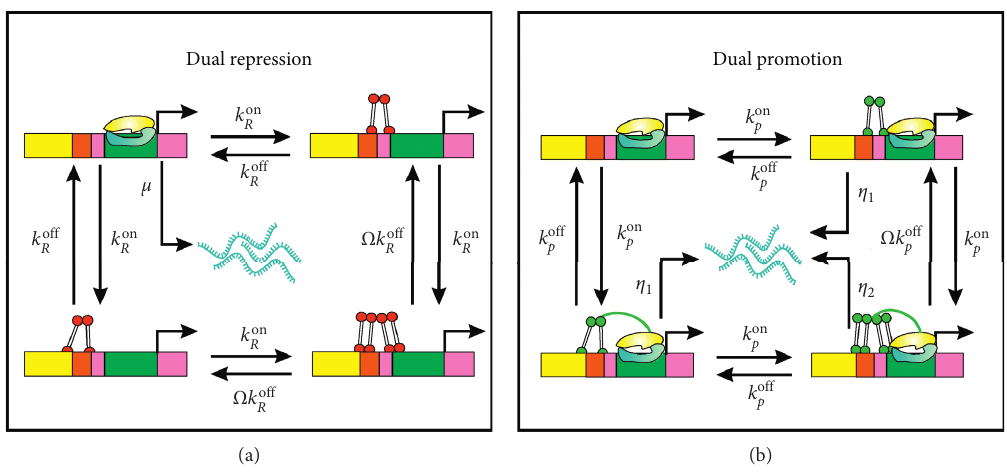
Figure 4: (a) Schematic diagram for dual repression structure. k on k off R represents binding rate, R represents dissociation rate, μ represents transcription rate, Ω represents cooperation binding degree, Ω � 1 represents independent binding, and Ω � 0 . 013 represents cooperation binding. (b) Schematic diagram for dual promotion structure. k on R represents binding rate, k off R represents dissociation rate, η and η 1 2 � f × η represent transcription rates, where η , f is the enhancement factor, Ω represents cooperation binding degree, Ω � 1 represents 2 1 independent binding, and Ω � 0 . 1 represents cooperation